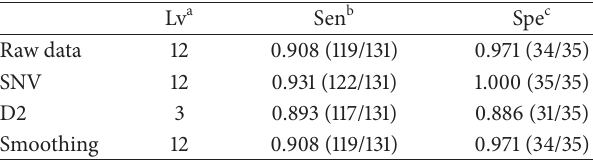
Table 2: Predicting results obtained by